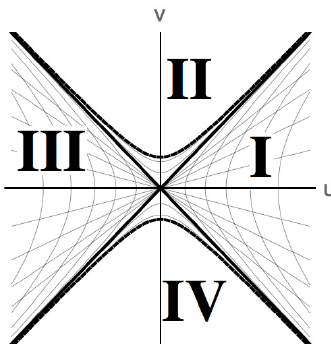
Figure 2. Kruskal